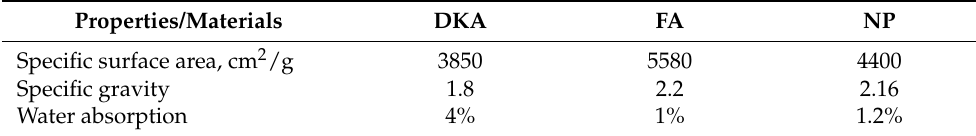
Figure 6. Particle size distributions of DKA, FA, and NP.